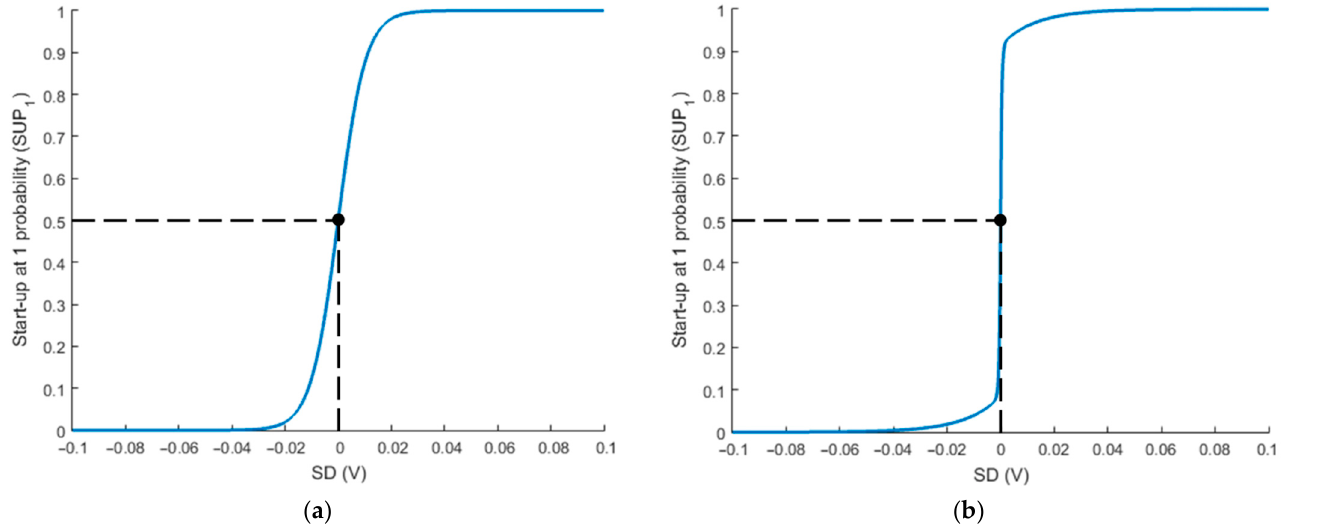
Figure 7. ( a ) Plot of the sigmoid function defined in Equation (3) after a fitting process (a = 1; k = 195.4 V − 1 ); ( b ) Sigmoid function that meets the requirements of the proposed model. The plot corre- sponds to the function defined in Equation (5) after a fitting process (m = 0.158; k 1 = 101.2 V − 1 ; k 2 = 2348 V − 1 ).